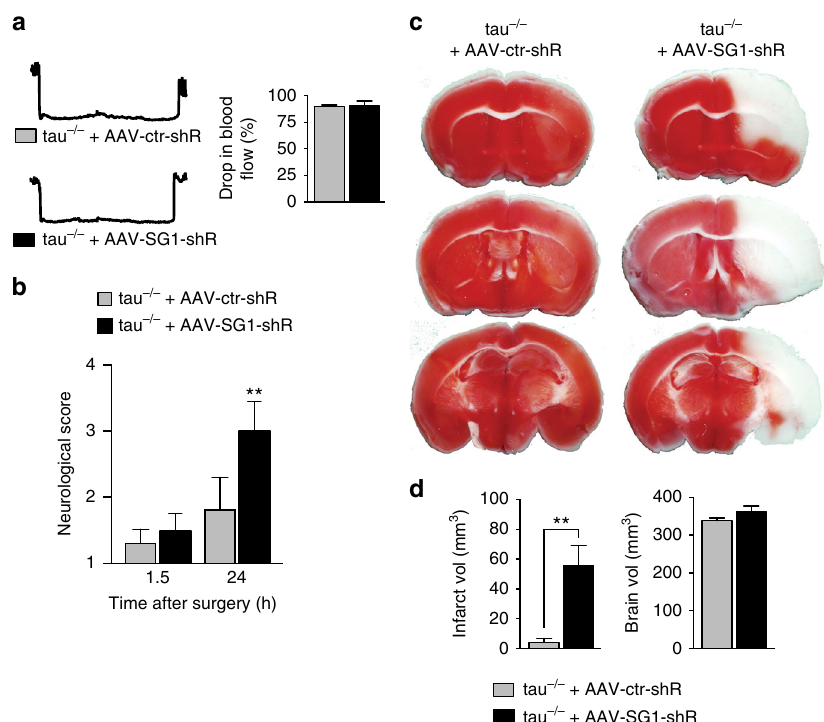
Fig. 9 Reducing SynGAP1 levels in tau − / − mice confers susceptibility to transient MCAO. a Blood fl ow was reduced to the same extend during transient MCAO in 2 month-old tau − / − injected with either AAV-SG1-shR or AAV-ctr-shR at P1-3 (not signi fi cant; N = 5; Student ’ s t -test). b Neurological scoring (with higher numbers indicating more severe impairments) revealed similar de fi cits directly after transient MCAO in AAV-SG1-shR- and AAV-ctr-shR- injected tau − / − mice, but thereafter, neurological de fi cits in AAV-SG1-shR-injected tau − / − mice progressed more severely than in AAV-ctr-shR-injected tau − / − mice (** p < 0.01; N = 5; two-way ANOVA (Tukey post hoc)). c Representative TTC-stained brain sections of tau − / − mice injected with AAV-SG1-shR or AAV-ctr-shR 24 h after transient MCAO (viable tissue stains red ). Note the large infarcted area ( white ) in AAV-SG1-shR-injected tau − / − mice, while only minimal brain damage was present in AAV-ctr-shR-injected tau − / − mice. d Infarct and brain volume quanti fi cation of serial TTC-stained sections